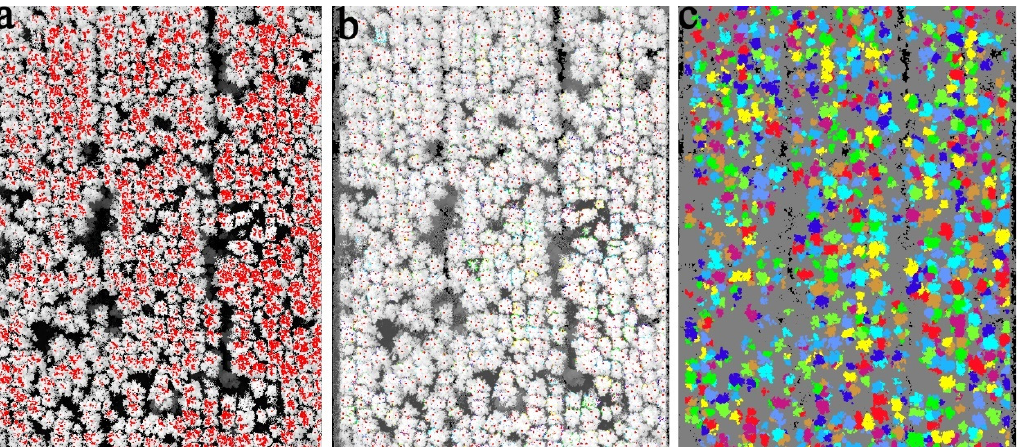
Figure 2. Single tree detection and segmentation in a poplar plantation using UAV-LS data. ( a ) Single tree detection results using CHM-based method; each red dot is predicted to be a single tree. ( b ) Single tree detection results using the voxel- based method; each red dot is a predicted location of each single tree. ( c ) Single tree segmentation results using single tree detection results from ( b ) the second method where each color cluster is one segment for an individual tree.